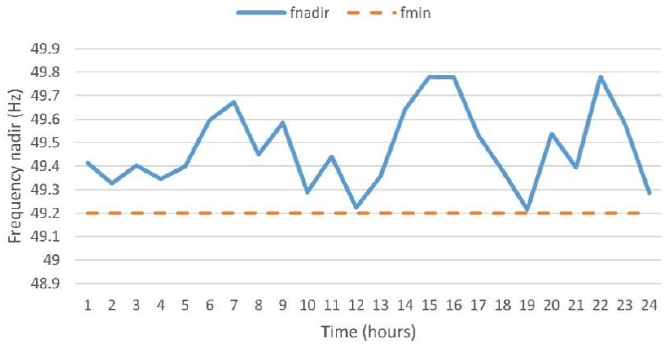
Figure 13. Frequency nadir with ESS providing FFR for Case 2.